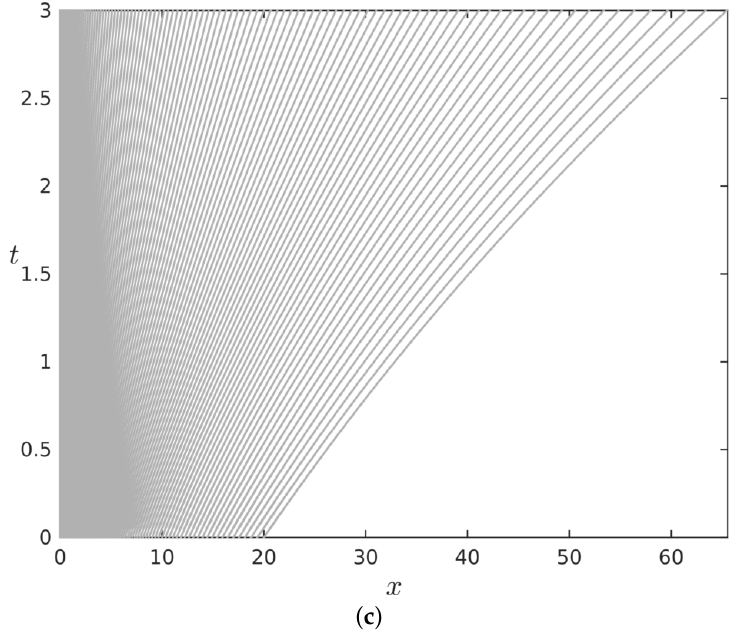
Figure 2. Numerical result of the expanding experiment with negative drift γ = − 0.1 < 0: ( a ) initial and terminal states of the numerical discretized solution; ( b ) initial and terminal states of the numerical discretized solution in semilogarithmic coordinates; and ( c ) trajectories of grid nodes. All numerical parameters for this computation are reported in Table 2 (middle